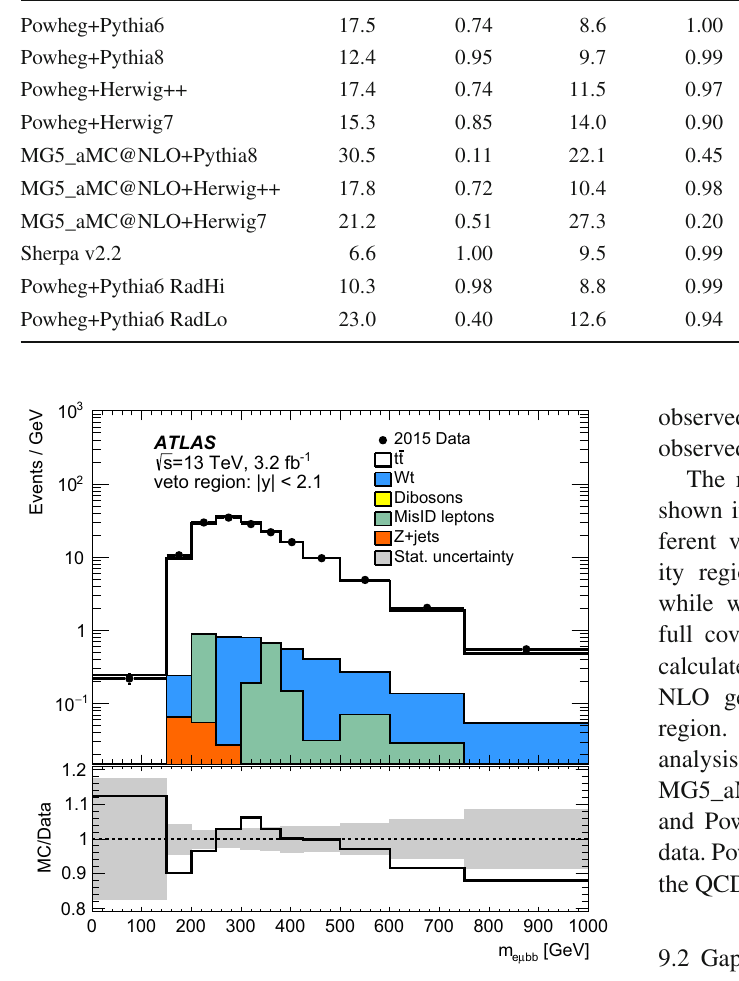
Fig. 13 Distribution of the reconstructed invariant mass of the e μ + 2 b -jets system m e μ bb in data, compared to simulation. The shaded band represents the statistical uncertainty in data. The lower plot